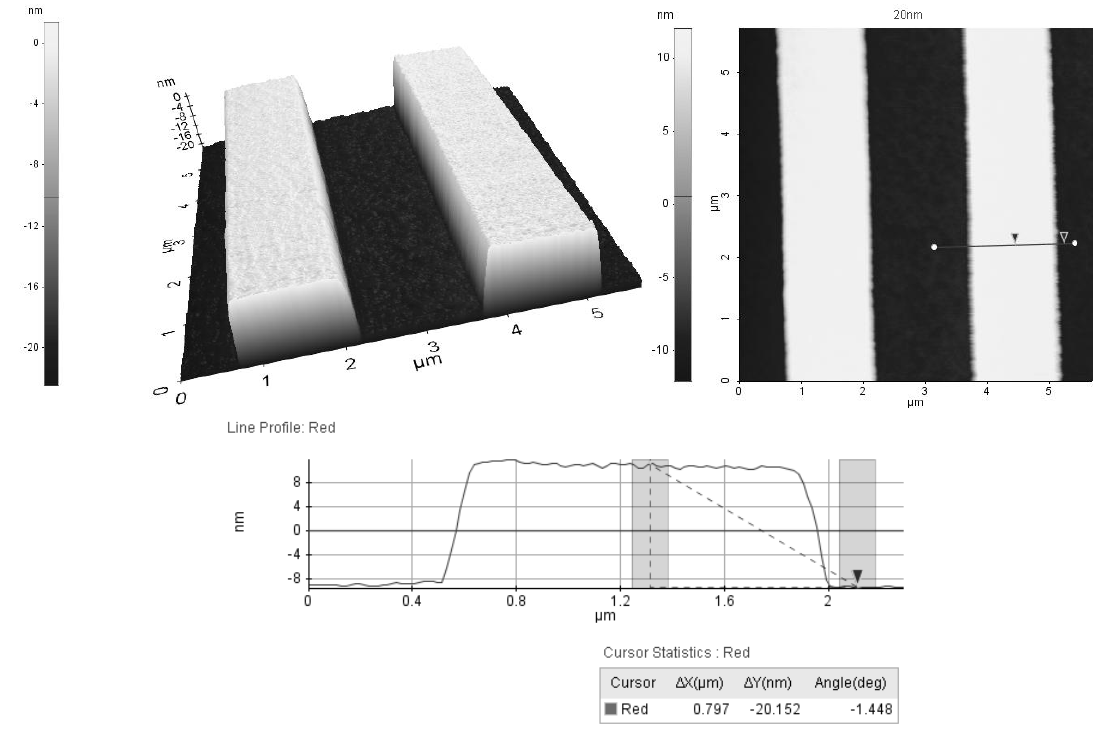
Figure 12. Non-contact AFM image of the 20 nm standard height